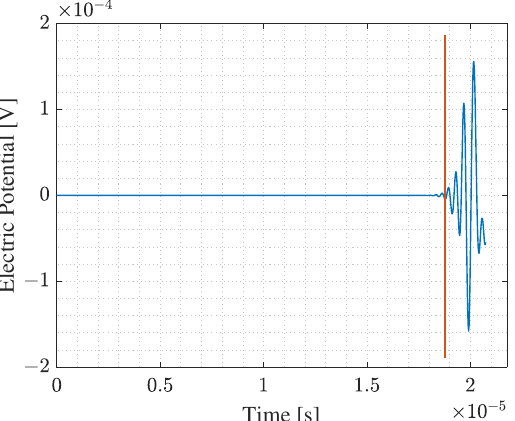
Figure 14. Electric potential gain computed from the central PMUT of the central cluster 12 of the receiving PMUT array at the end of the